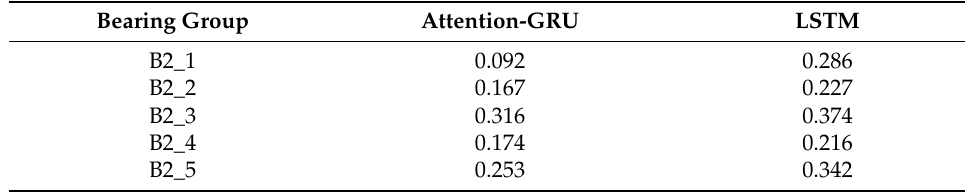
Table 6. RUL prediction error of LSTM and our